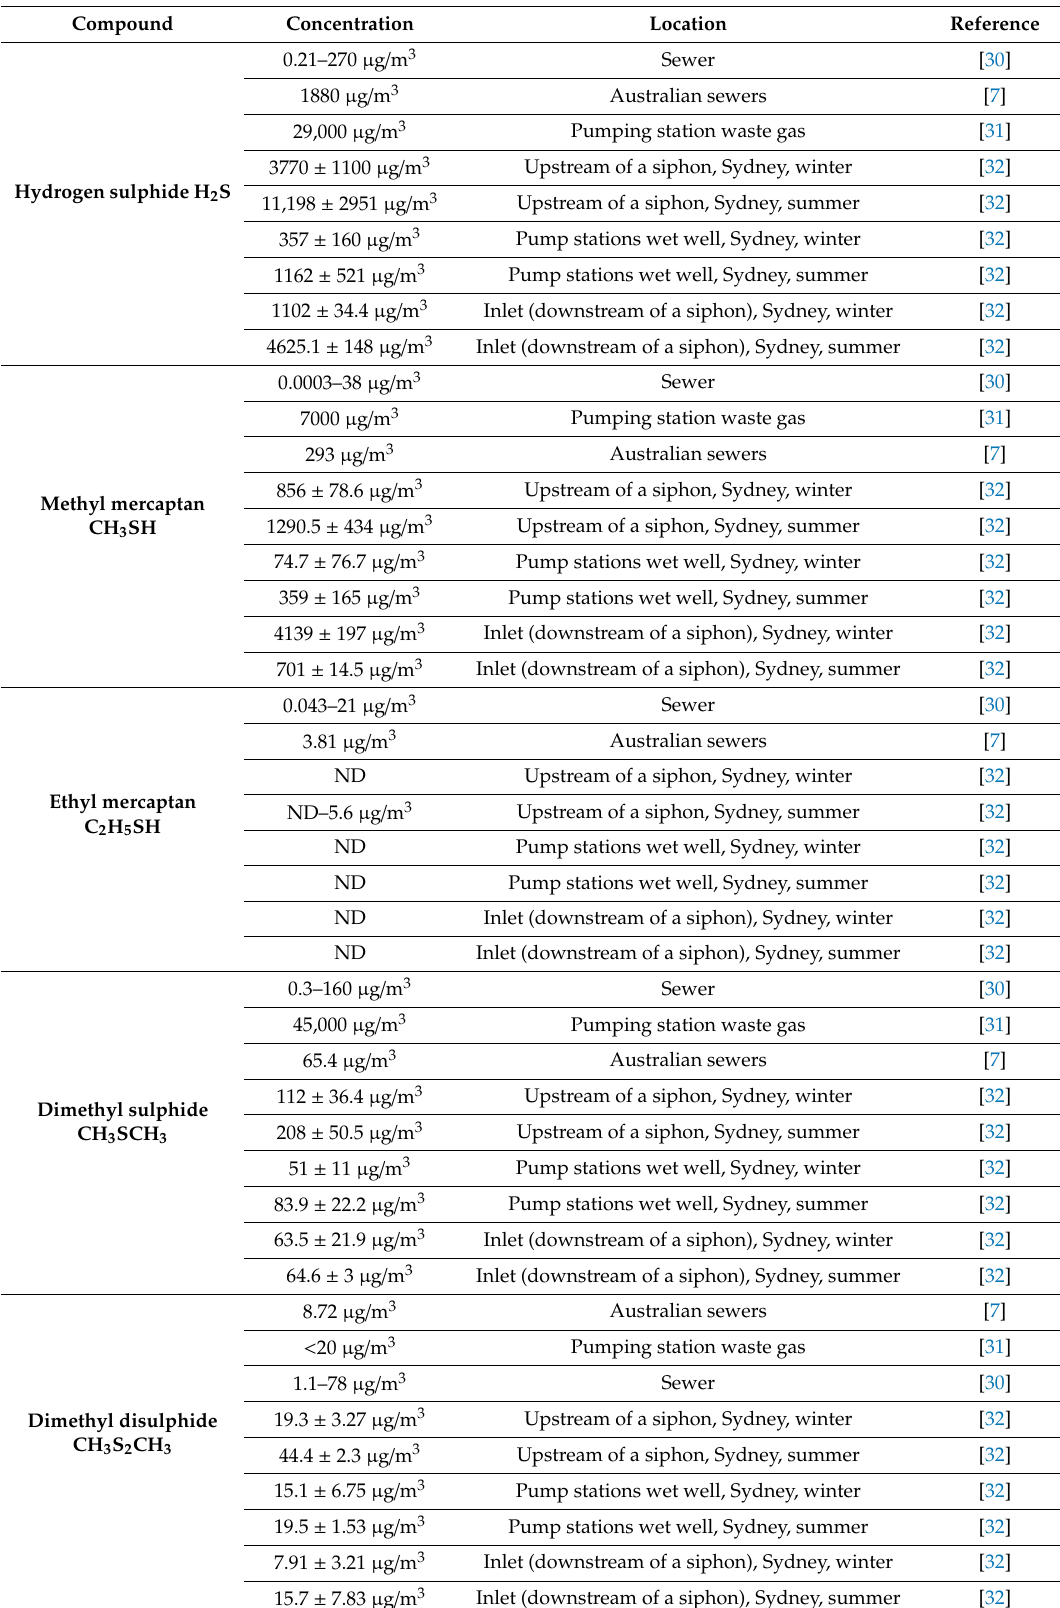
Table 2. Examples of malodorous substances concentrating at various points in a